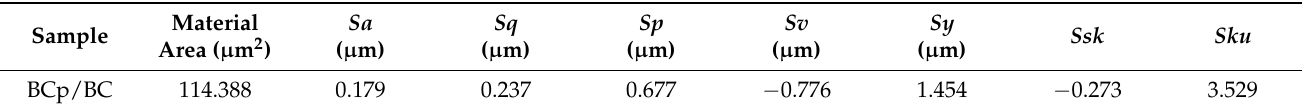
Table 2. Values obtained from AFM analysis.